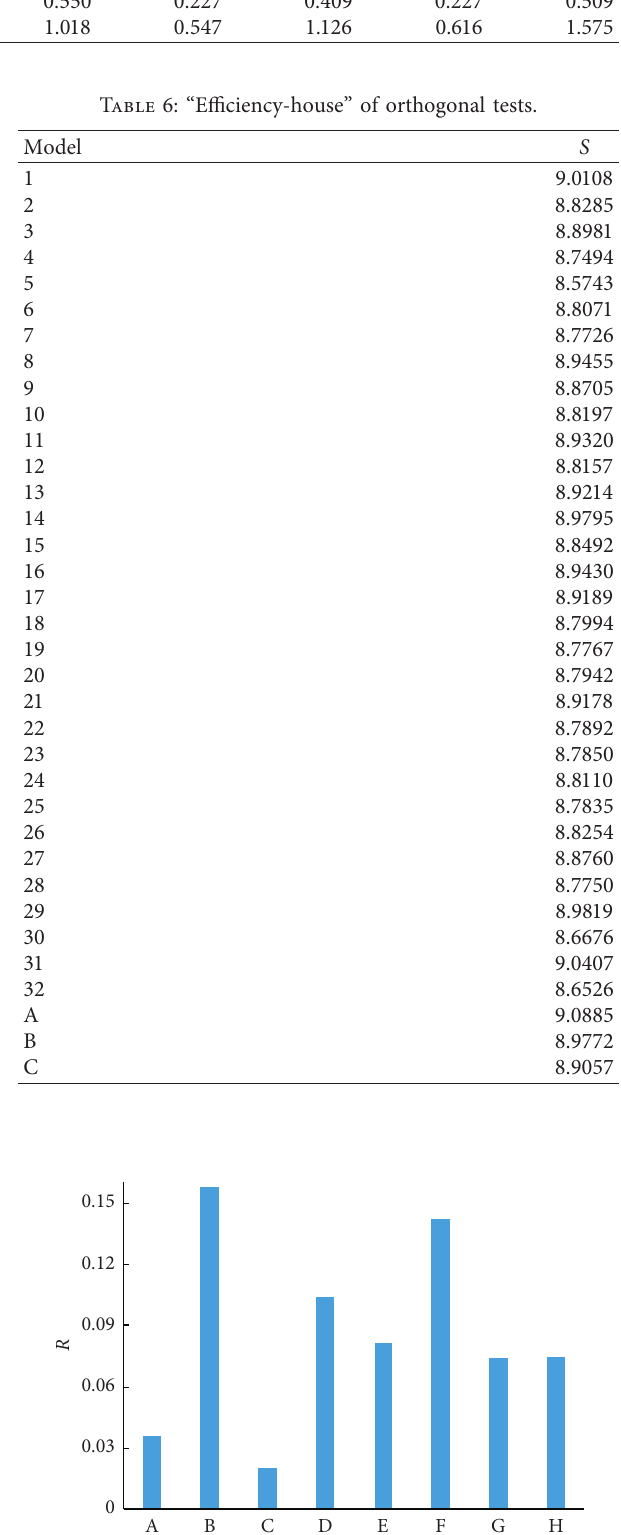
Figure 11: Level of influence of decision variable on